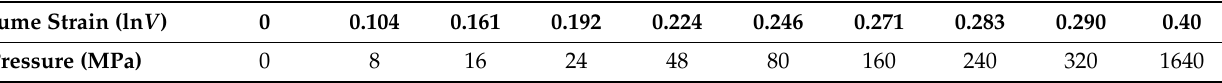
Table 5. Pressure versus volume strain.